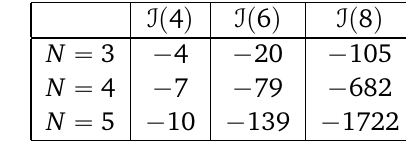
. On the left are indices U p 1 q N